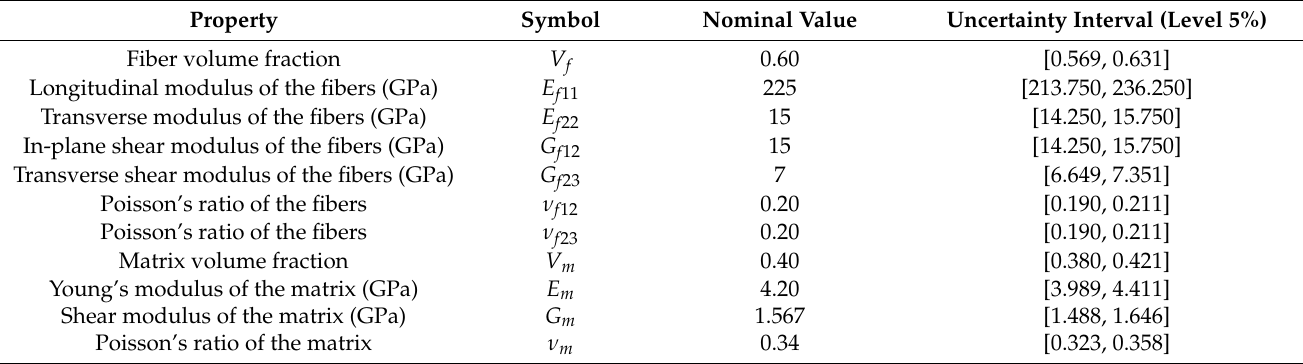
Table 1. Nominal values and uncertainty intervals of the elastic properties of the fibers and the matrix of the AS4-3501/6 composite ply. The data have been taken from